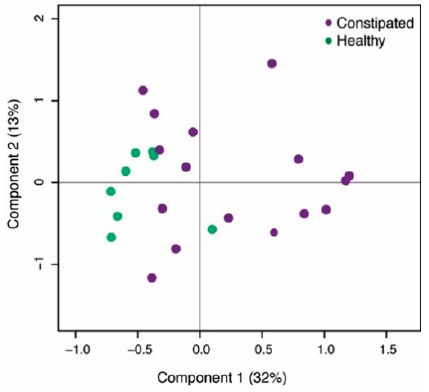
Figure 1. Principal co-ordinate analysis (PCoA) of the baseline microbial differences between the two study populations. Table 2. Relative abundance of bacterial taxa showing a statistical difference between healthy and constipated patients at baseline. Fc—fold change of taxa in constipated versus healthy subjects. Taxa Constipated Healthy